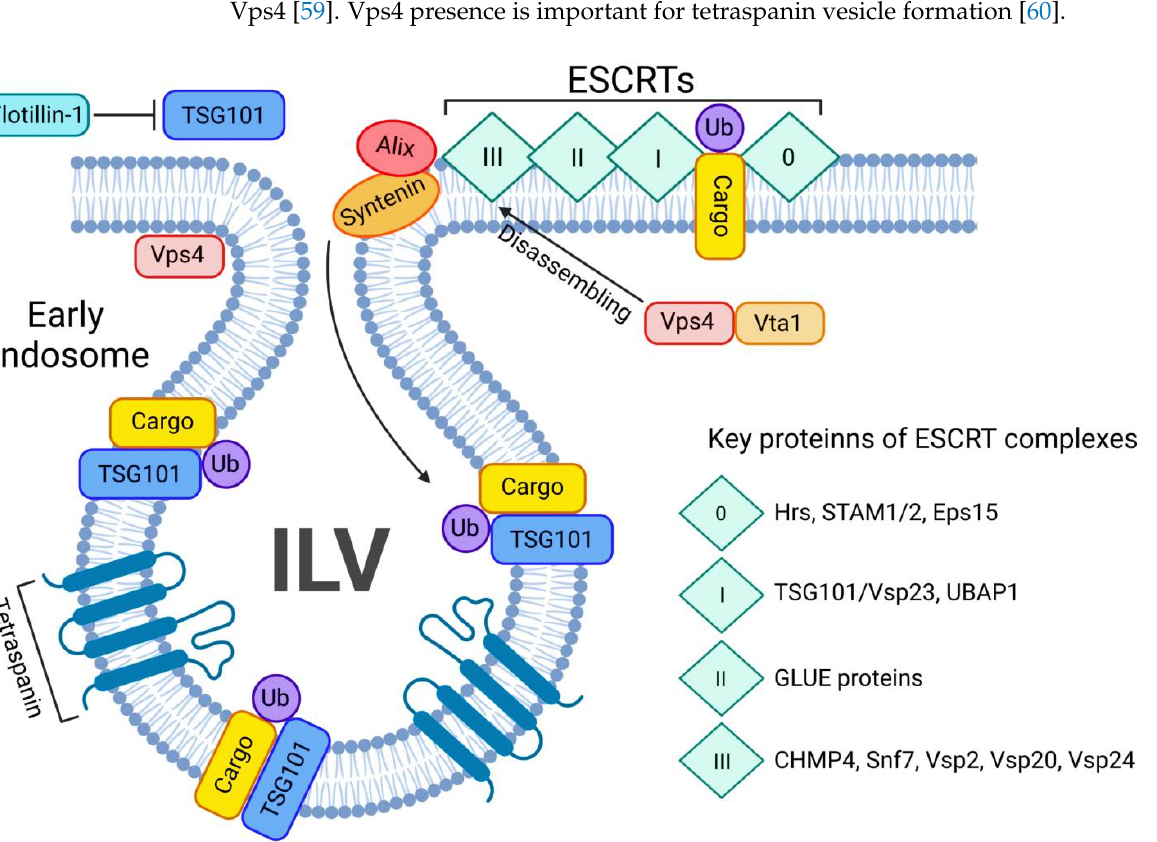
Figure 4. ESCRT-dependent pathway of exosome biogenesis and release. The ESCRT-dependent exosome biogenesis starts with assembling all 4 ESCRT complexes on the ubiquitin-bound cargo (Ub-cargo). The process is tightly regulated by key proteins such as Alix and syntenin. Once ESCRTs bind the Ub-cargo, TSG101 navigates the cargo inside the ILV and the Vsp4/Vta1 complex will disassemble the ESCRT 0-III complex. Tetraspanins will favour the budding of the ILV.